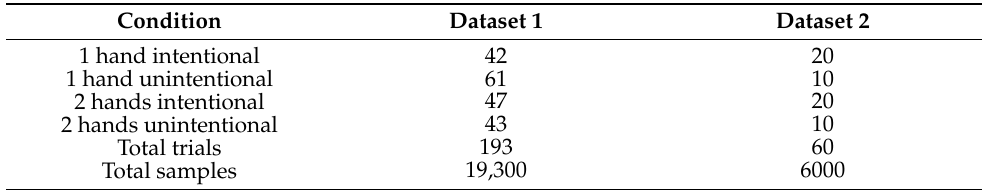
Table 3. Collected data on unintentional vs intentional clicks for Dataset 1.